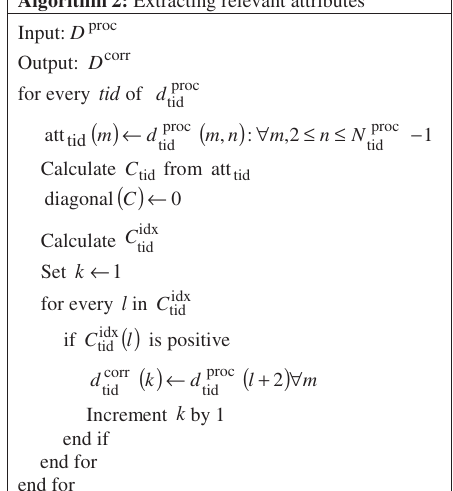
Figure 3: Pseudo Code of the Algorithm to Extract the Relevant